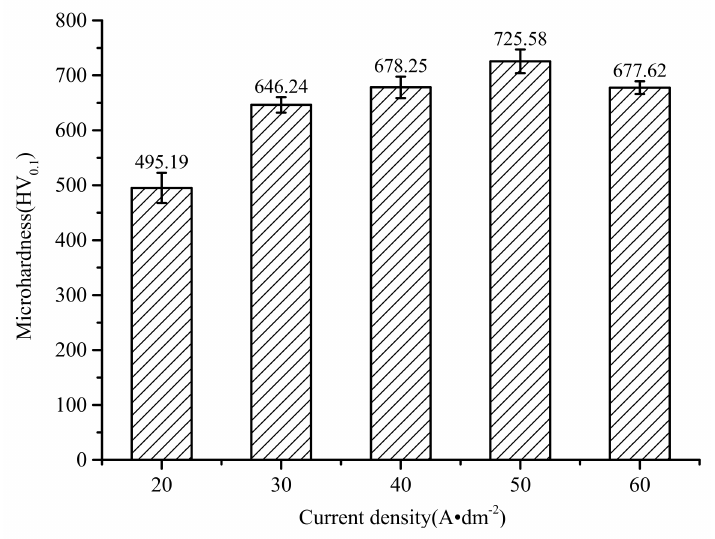
Figure 7. Microhardness of Ni–P alloy coatings prepared by immersion-assisted jet-electrodeposition at different current densities.